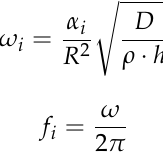
Table 10 . Some v alues of α i for some free vibration frequencies.